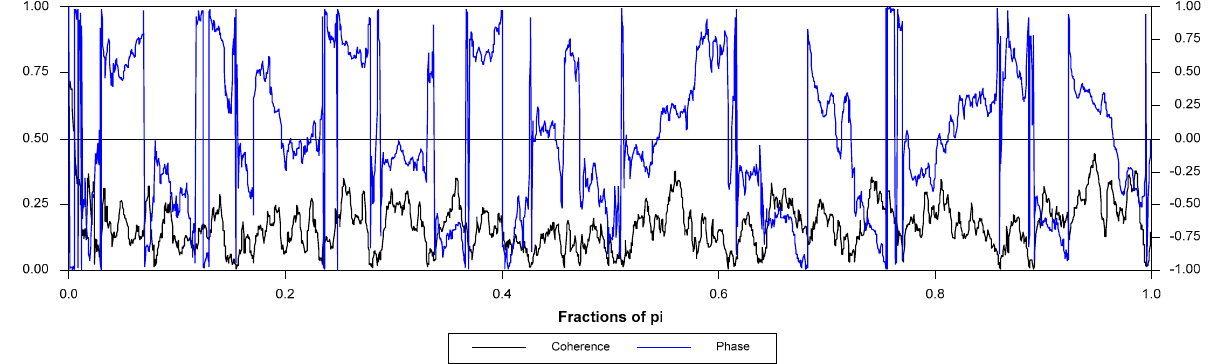
Figure 6. Coherence and phase diagrams of detrended SPRB and CC.